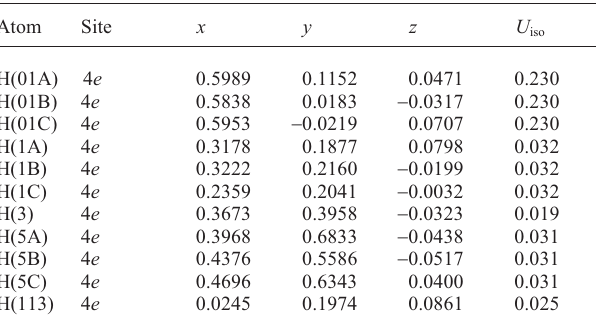
Table 2. Atomic coordinates and displacement parameters (in Å 2 ) .